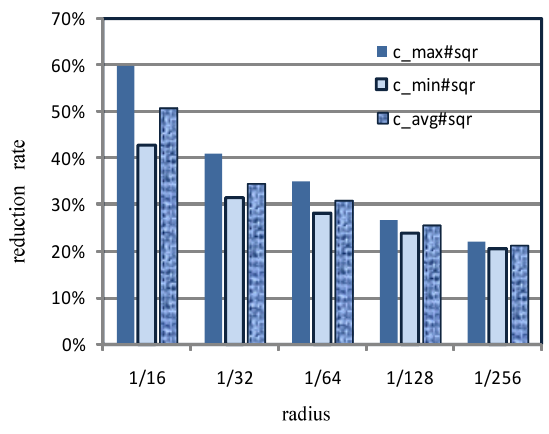
Figure 11. The subarea reduction rates. The number of candidate points n cand and the number of outer points n outer are discussed in the following. Table 5 provides the values of n cand for each algorithm used in the comparison. When the radius went from 1/16 to 1/256, n cand of c_max went from 179,853 to 109,639, n cand of c_min went from 148,369 to 108,609, and n cand of c_avg went from about 162,264 to 109,121. With the same radius, n cand of sqr went from 123,374 to 89,841, which was less than the values for c_max, c_min, and c_avg. In c_max, when the radius is 1/16, n cand was 179,853 with a value of n inner of 89,209, and the ratio of n cand to n inner was about 2.02. When the radius was from 1/16 to 1/256, the ratio of c_max ranged from about 2.02 to 1.23, the ratio of c_min went from about 1.67 to 1.22, and the ratio of c_avg went from about 1.82 to 1.22. Based on the same radius, the ratio of sqr went from 1.38 to 1.01, which was less than the values for c_max, c_min, and c_avg. Table 5. The number of candidate points.